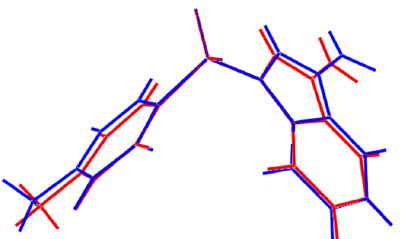
Figure 5. Superposition of the two independent molecules comprising the asymmetric groups are superimposed. The inverted form of the unit of 1 [16], drawn so that the SO 2 S2-containing molecule (blue image) has been employed.